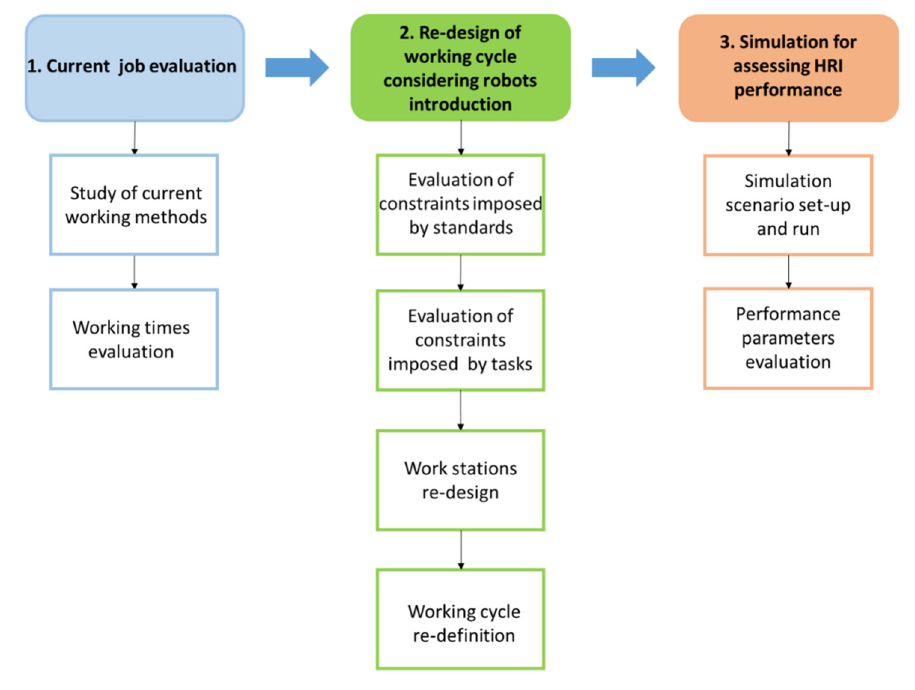
Figure 1. Methodological procedure for HRI definition.